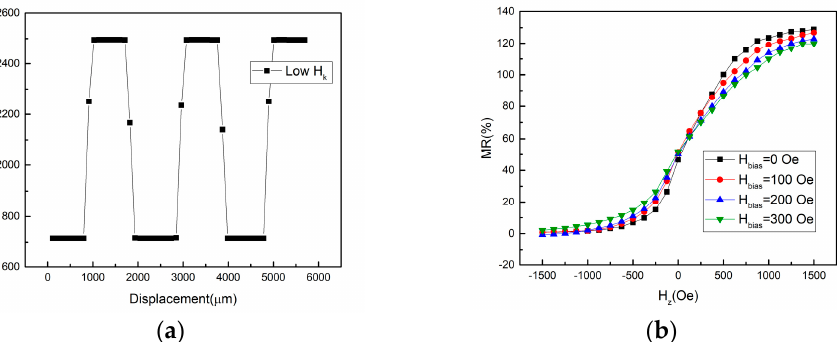
Figure 5. ( a ) The square output caused by the small H c /H k of SL. ( b ) The RH curves influenced by different magnitudes of bias field.